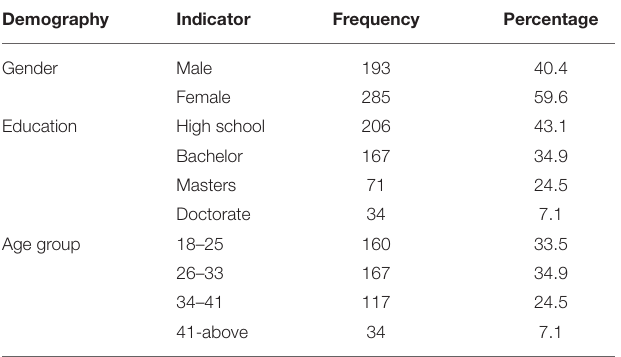
TABLE 11 | Multicollinearity